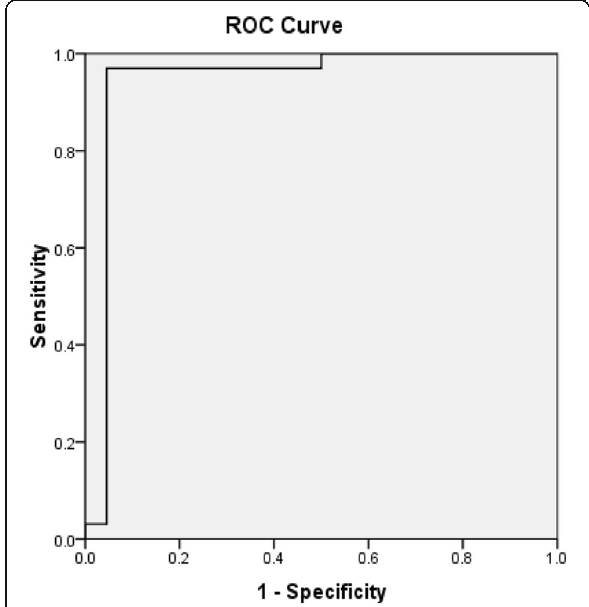
Fig. 6 Receiver operating characteristic (ROC) curve of the ADC